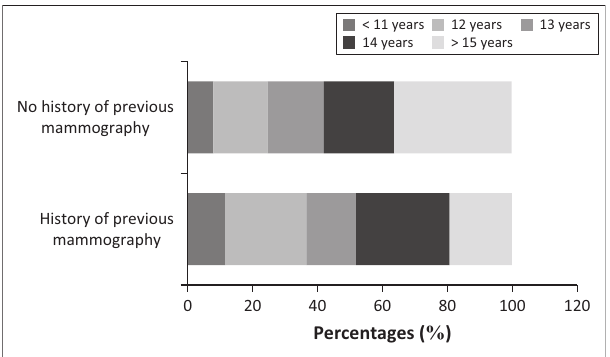
FIGURE 1: The association between menarche age in one’s youth and mammography